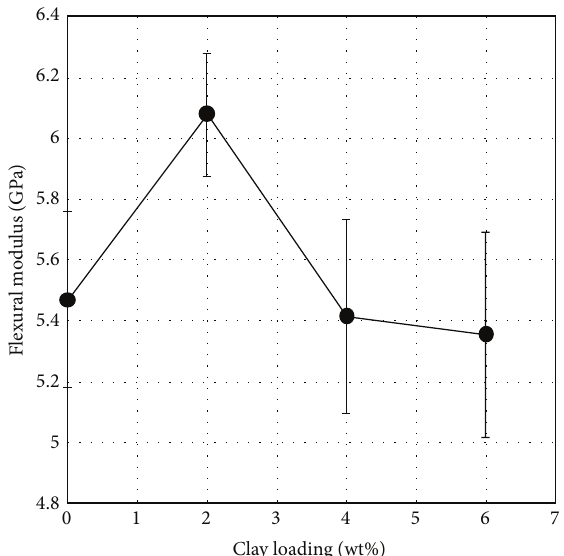
Figure 5: Effect of clay loading on the flexural modulus of UP/glass fiber/clay composites.